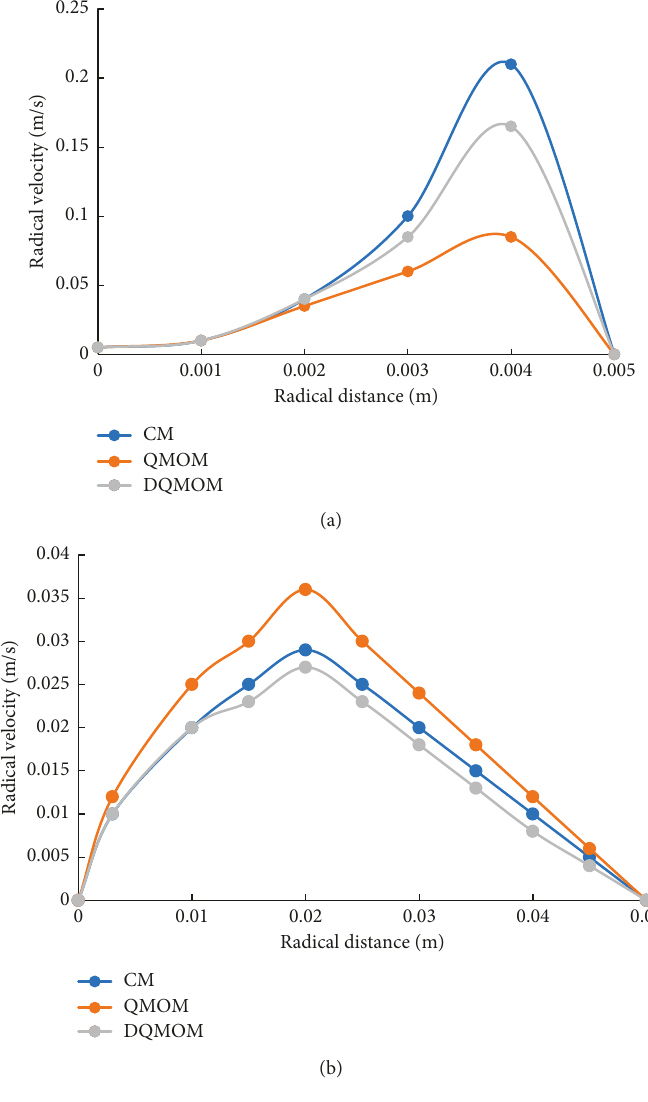
Figure 6: The velocity of disperse phase along the radical distance (a) h � 0.04m and (b) h � 0.2m in the extractor.